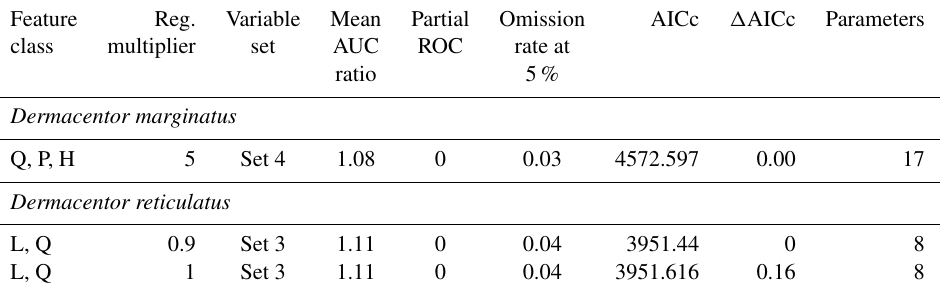
Table 2. Parameter settings selected in the process of model calibration, to produce final models for Dermacentor marginatus and D. reticu- latus . Reg. denotes regularization; AUC denotes area under the curve; ROC denotes receiver operating characteristic; AICc denotes Akaike information criterion corrected for small sample